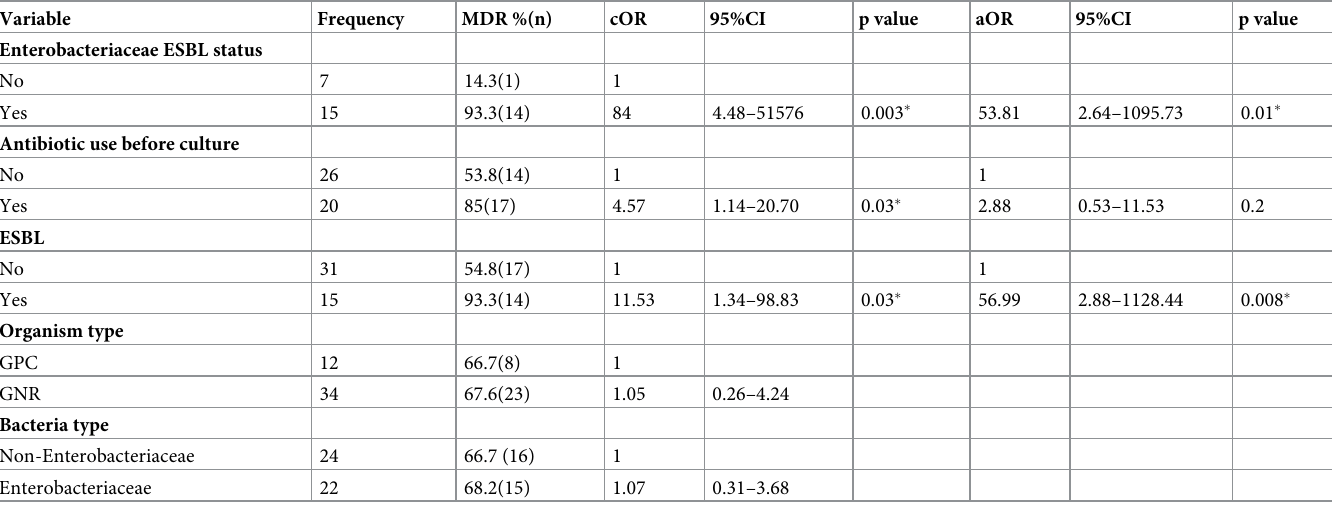
Table 2. Factors for isolation of multidrug resistant bacteria in confirmed Bloodstream infection. Variable